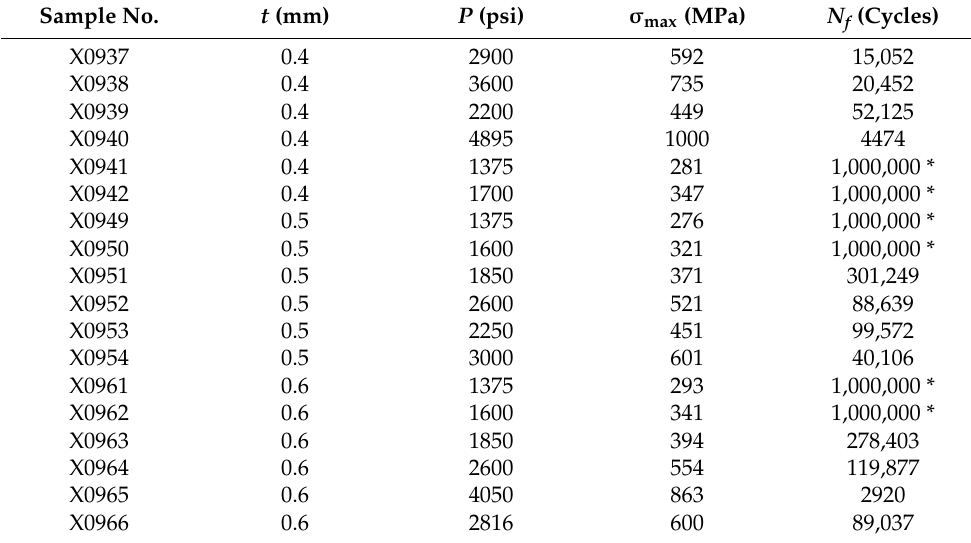
Figure 6. Pressure impulse waveform. Table 4. Pressure fatigue test results.